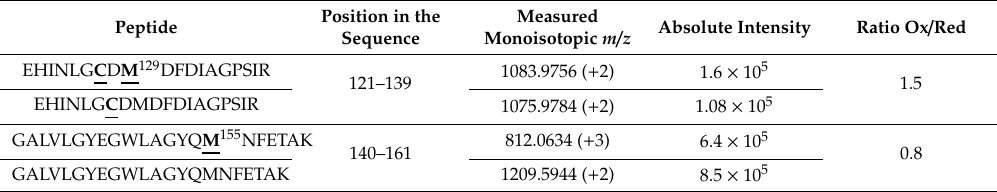
Table 1. Comparison of the absolute intensities of molecular ions of selected sulfur containing tryptic peptides found in the analysis of hVDAC1 reduced with dithiothreitol (DTT), carboxyamidomethylated, and digested in-solution. Position in the Measured Absolute Intensity Ratio Ox / Red Peptide Sequence Monoisotopic m / z EHINLG C D M 129 DFDIAGPSIR